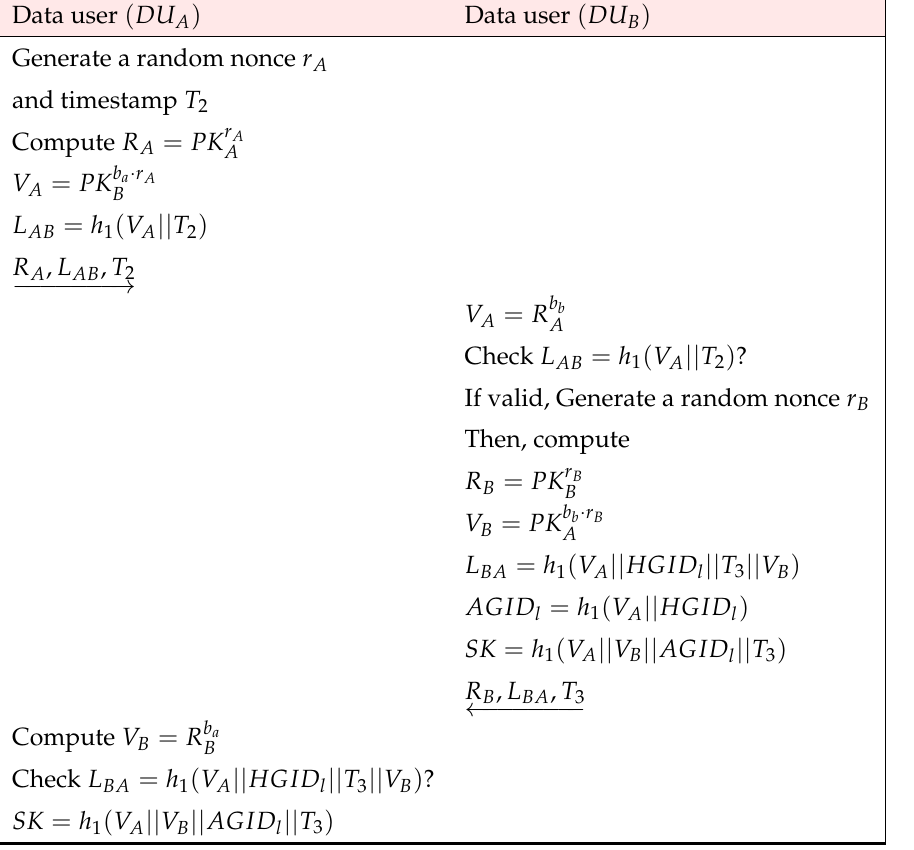
Figure 6. Authentication for delegation